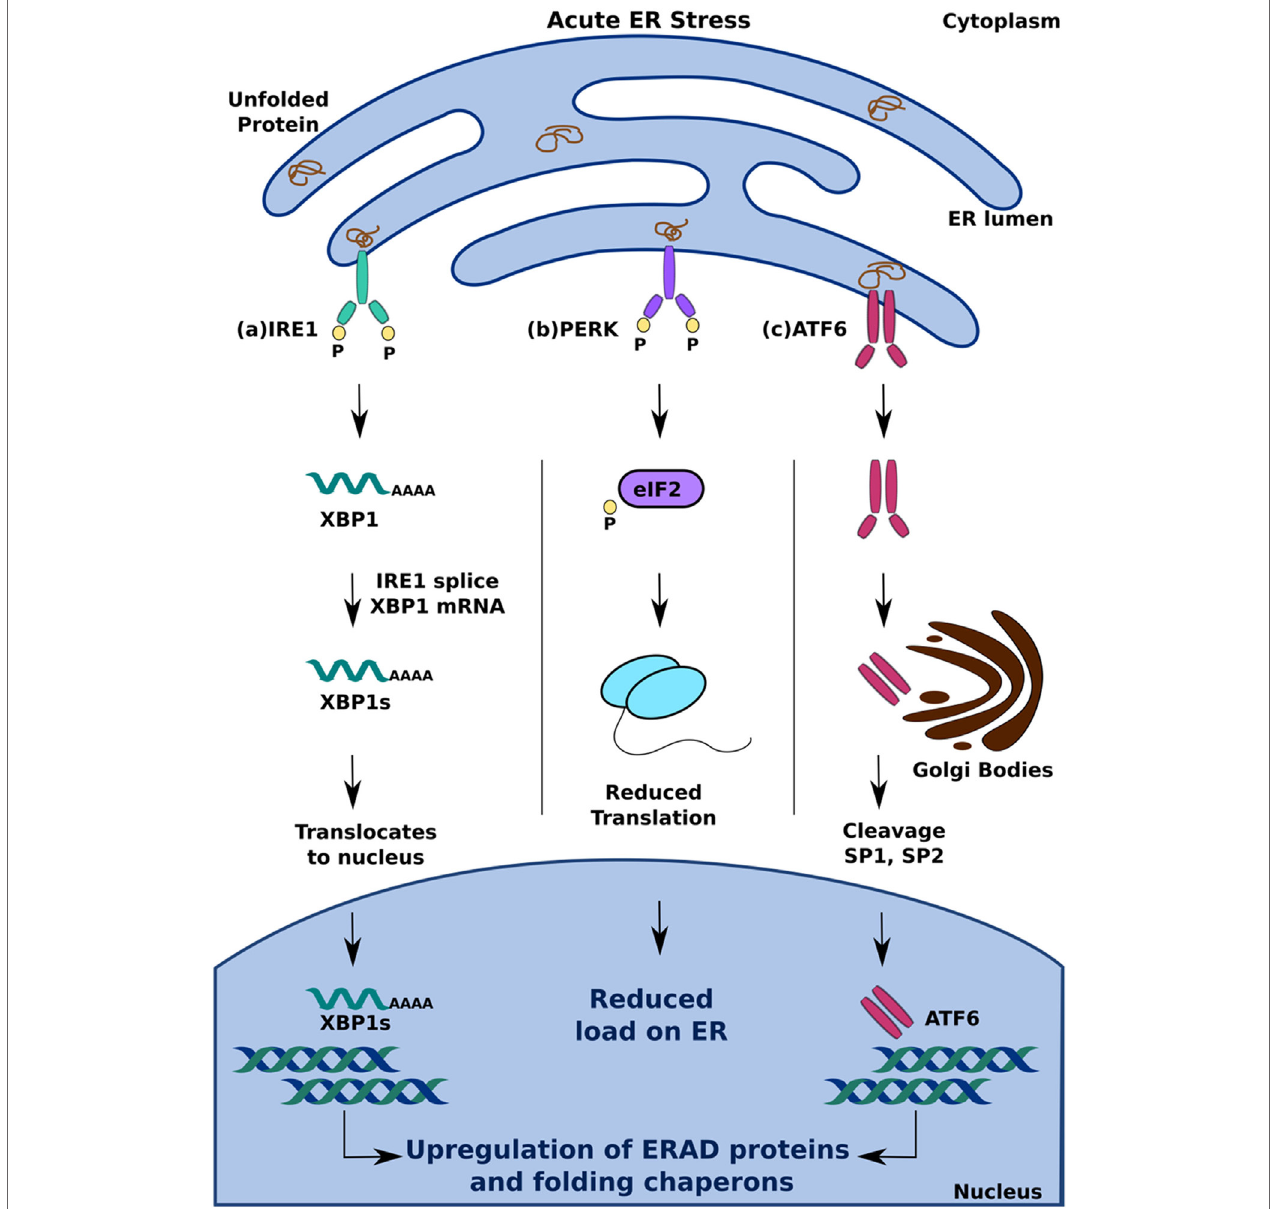
FigURe 1 | Adaptive unfolded protein response (UPR) signaling under acute endoplasmic reticulum (ER) stress. Accumulation of unfolded protein triggers UPR by activation of (A) inositol-requiring 1, (B) PERK, and (C) activating transcription factor 6. This leads to upregulation of ER-associated degradation protein and folding chaperons to mitigate ER stress and maintain